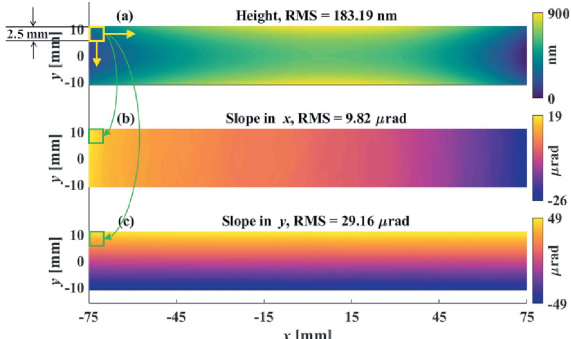
Figure 11 Desired removals of height ( a ), slope in x ( b ) and slope in y ( c ) from the sphere to the elliptical cylinder, where the slope maps are generated from the height map with the 2.5 mm sliding window.